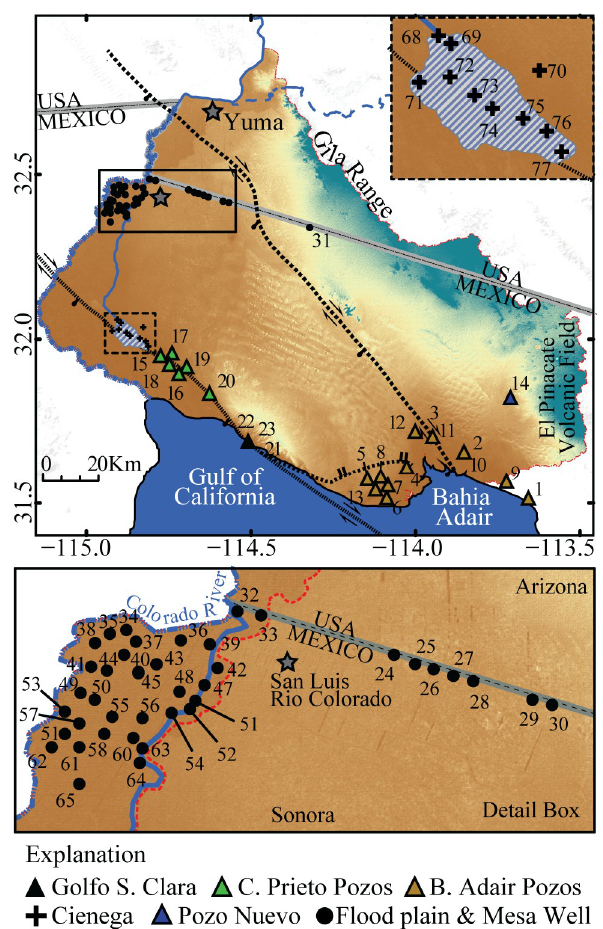
Figure 4. Location of sampling sites in study area. Red dashed line in detail box separates floodplain (west) from the San Luis and Yuma mesas